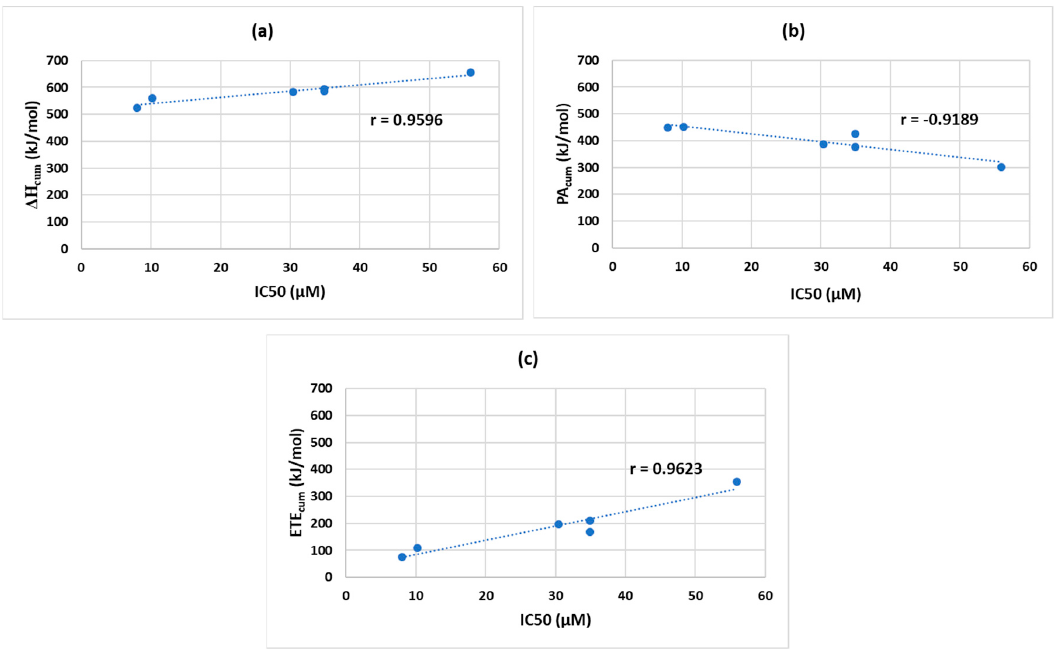
Figure 6. Graphical representation of the enthalpy deviation of each compound from the value of the reference compound: ( a ) ∆ ( ∆ H cum ), ( b ) ∆ PA cum , ( c ) ∆ ETE cum and ( d ) ∆ IC50. We also determined the Pearson correlation coefficients (r) between the IC50 and ∆ H cum / PA cum / ETE cum values to determine which parameter of the SPLET mechanism better correlates with the IC50 values. Although the IC50 order looks slightly different from the order of ∆ H cum (Table 6), their correlation was quite impressive: r = 0.9596 with a 95% confidence interval (0.6692, 0.9957) based on Fischer’s Z-transformation (Figure 7a). The PA cum showed a strong negative correlation with IC50: r = − 0.9189 with a 95% confidence interval ( − 0.9912, − 0.4222) (Figure 7b). The r of IC50 to ETE cum was 0.9623 with a 95% confidence interval (0.6882, 0.9960) (Figure 7c).